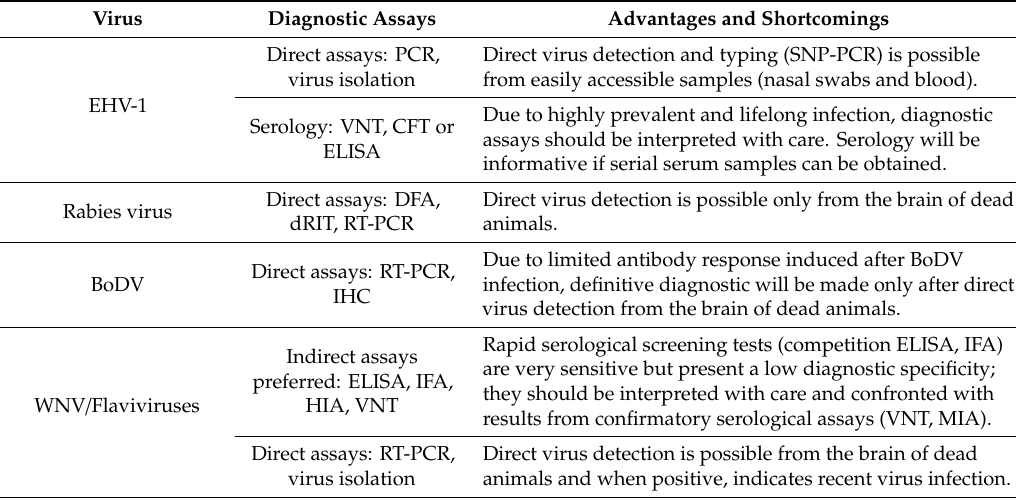
Table 1. List of diagnostic assays available against equine neuropathogenic viruses enzootic in Europe. PCR = polymerase chain reaction; RT = reverse transcription; VNT = virus neutralization tests; CFT = complement fixation test; DFA = direct fluorescence assay; dRIT = direct rapid immunohistochemistry test; IHC = immunohistochemistry; IFA = indirect fluorescence assay; HIA = hemagglutination inhibition assay; MIA = multiplex immunoassay.